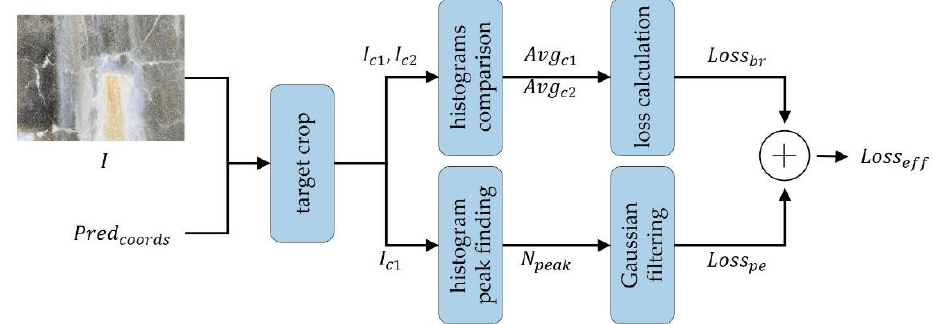
Figure 12. Structure of the 𝐿𝑜𝑠𝑠 𝑒𝑓𝑓 computation.